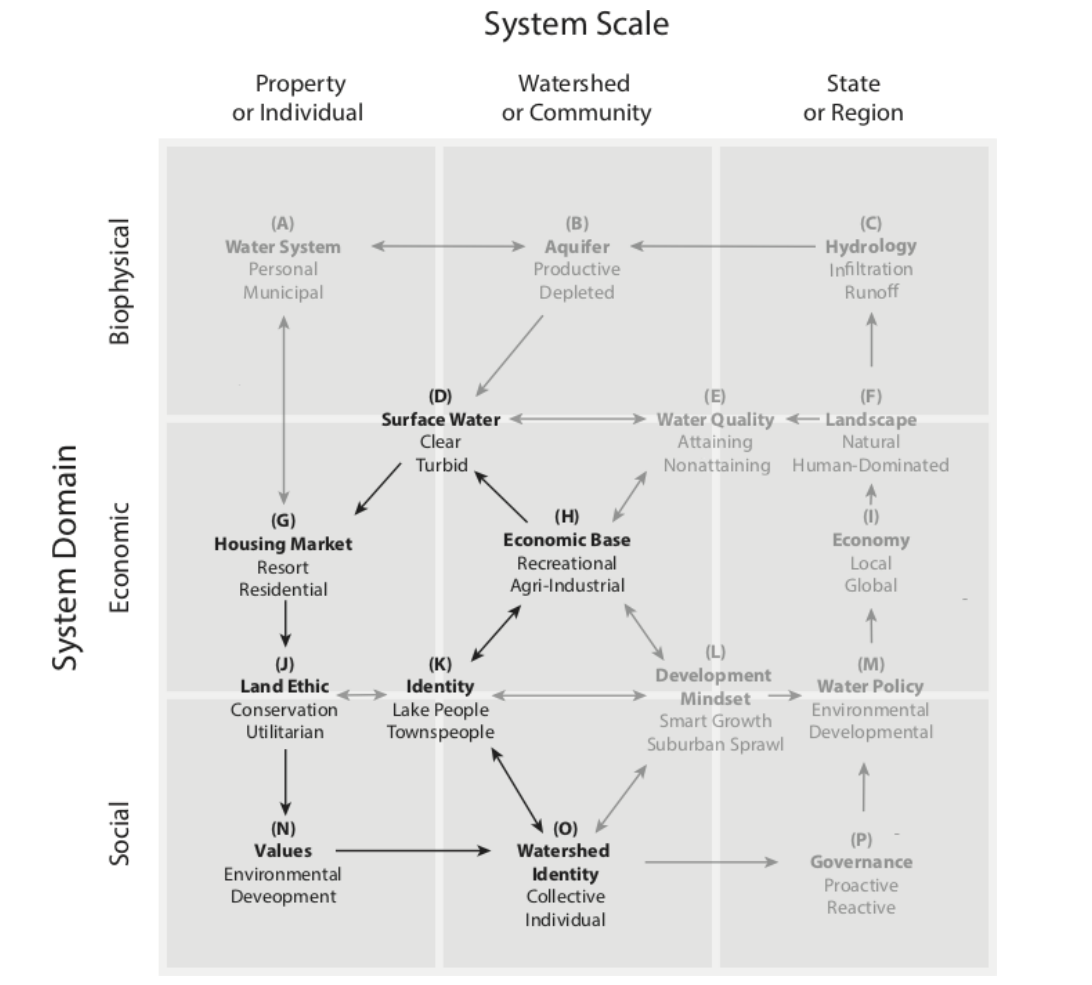
Fig. 4 . The identity-based resilience dynamic. Residents on Lake Beulah consider themselves separate from the surrounding population, influencing their decision making and the ecological status of the